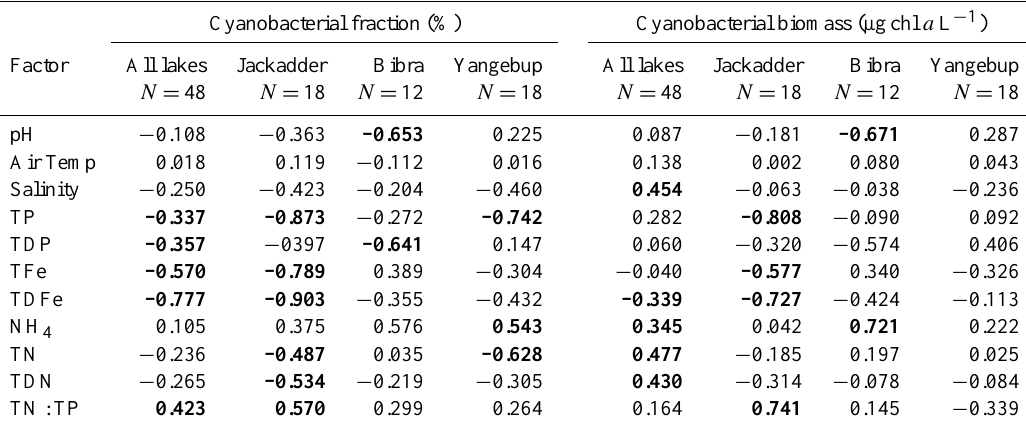
Significant ( p< 0.05) correlations are highlighted in